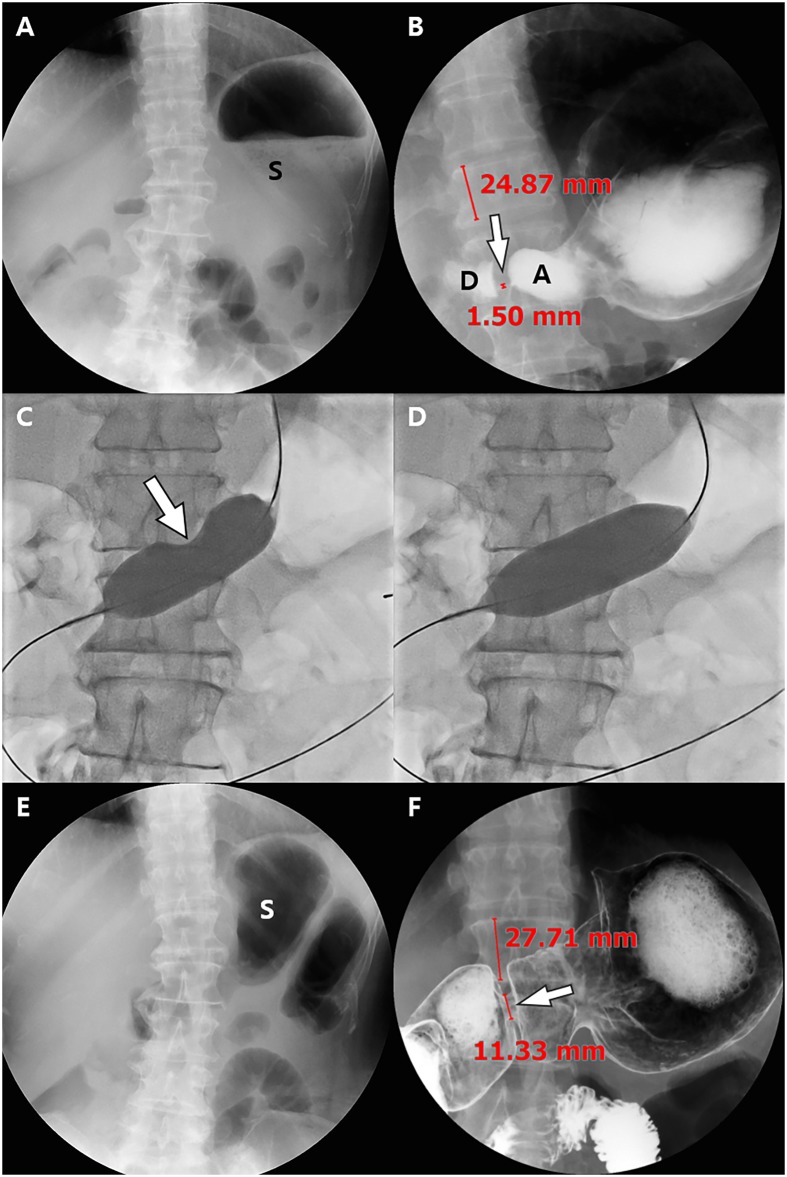
Images of a 60-year-old woman with impaired pyloric function after laparoscopy-assisted pylorus-preserving gastrectomy (PPG).(A) On the scout image obtained 13 days after PPG, approximately 1/2~3/4 of the stomach (S) is filled with residual food material, resulting in a semi-quantitative score for residual food of 2. (B) On upper gastrointestinal series (UGIS), the pyloric canal is severely narrowed (arrow) and the width of the pyloric canal and the height of the adjacent vertebral body are 1.5 and 24.87, respectively, with a pyloric canal-to-height of vertebral body ratio of 6.03. A = antrum, D = duodenum. (C), (D) Fluoroscopic images show dilatation of the stenotic pyloric canal with a 25 mm x 4 cm long balloon until the balloon deformity disappears. (E) The scout image of UGIS obtained 11 months after balloon dilatation shows no residual food material within the stomach, resulting in a markedly improved semi-quantitative score for residual food of 5. (F) UGIS shows a dilated pyloric canal (arrow), and the width of the pyloric canal and the height of the adjacent vertebral body are 11.33 and 27.71, respectively. Therefore, the pyloric canal-to-height of vertebral body ratio was also markedly increased to 40.89. Finally, her subjective symptom score of post-prandial discomfort was also markedly decreased from 10 to 3 after the balloon procedure.